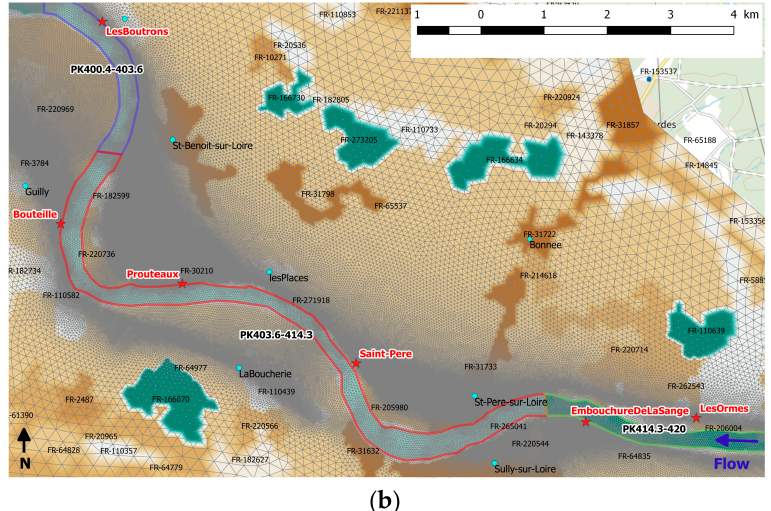
Figure 1. Study area: ( a ) domain of interest; ( b ) zoom area. Red stars indicate breach locations (weak points) and blue dots are points of interest in the floodplain. Colored surfaces correspond to friction coefficient areas. Range of variation of friction coefficients in the floodplain is reported in the legend.